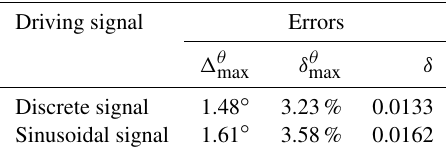
Figure 10. Comparison between actual and theoretical bending an- gle under sinusoidal signals. Table 1. Errors analysis of the improved hysteresis